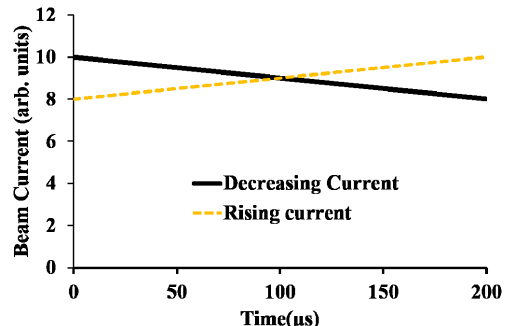
FIG. 12. H − beam size evolution when the beam current grows